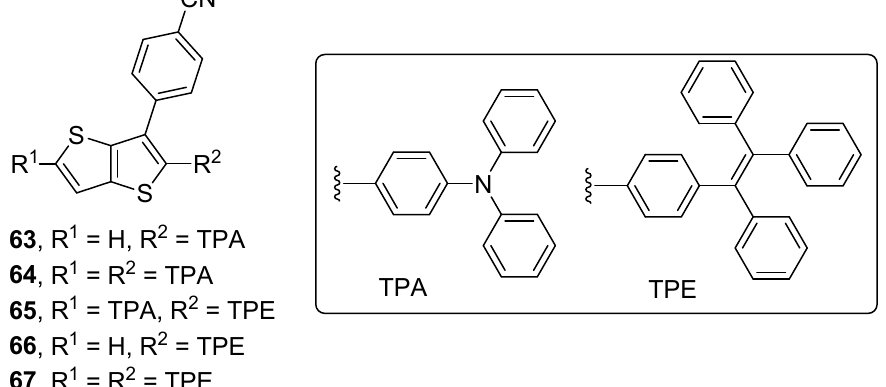
Table 3. Emissive properties and brightness of the OLEDs containing polymers 62a – c .